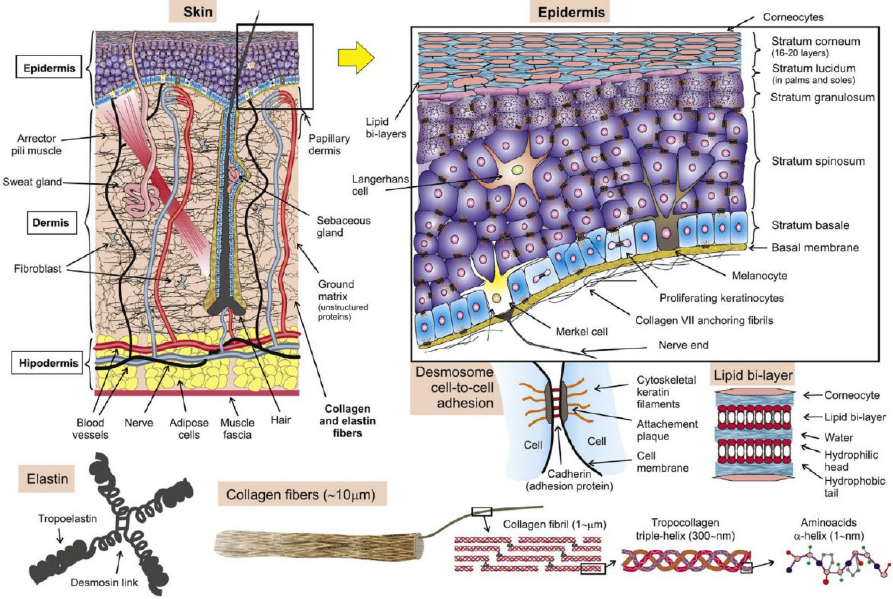
Figure 6. The structures of the skin (Reprinted with permission from Ref. [76]. Copyright 2017, Elsevier).